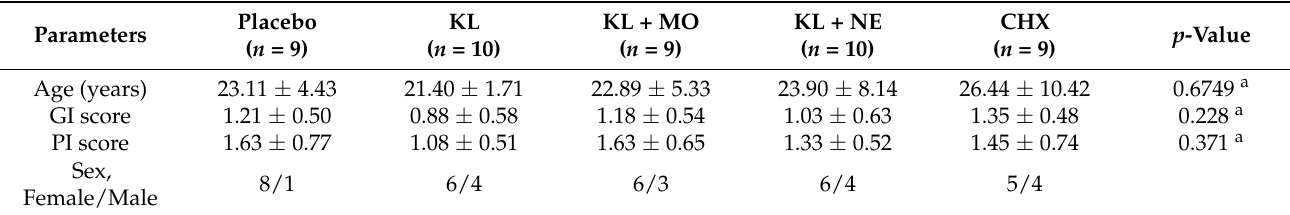
GI and PI scores from baseline to day 15 in each experimental group are shown in Figure 4. Intragroup comparison of GI scores on day 15 in the KL, KL + MO and